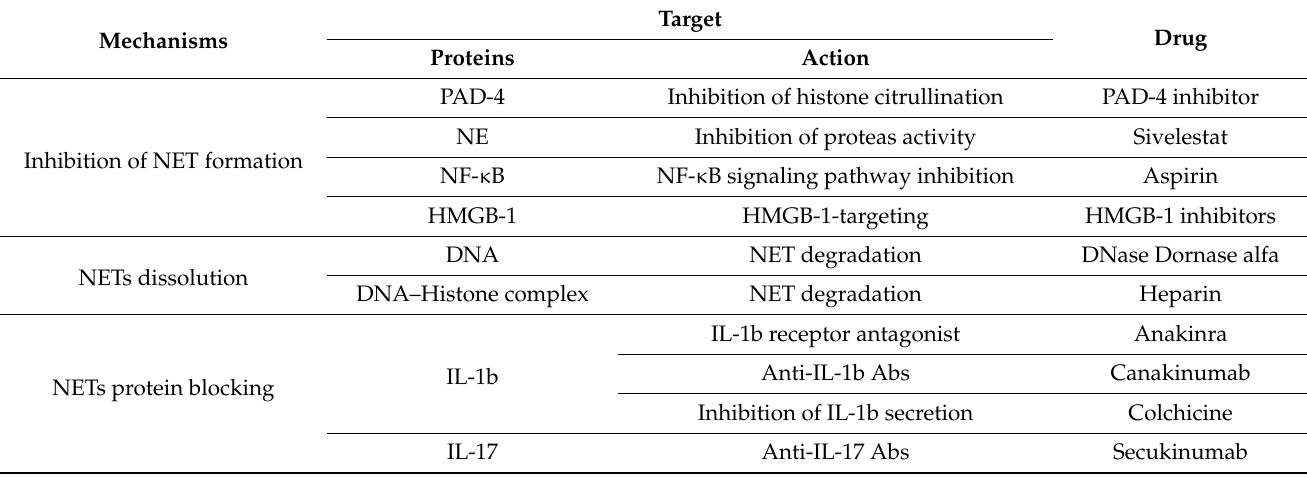
Table 3. Therapeutic targeting of Neutrophil Extracellular Traps. Peptidylarginine deiminases -4, PAD-4; Neutrophil Elastase, NE; High Mobility Group Box 1, HMGB-1; Deoxyribonucleic Acid, DNA; Interleukin-1b, IL-1b, and Interleukin- 17,